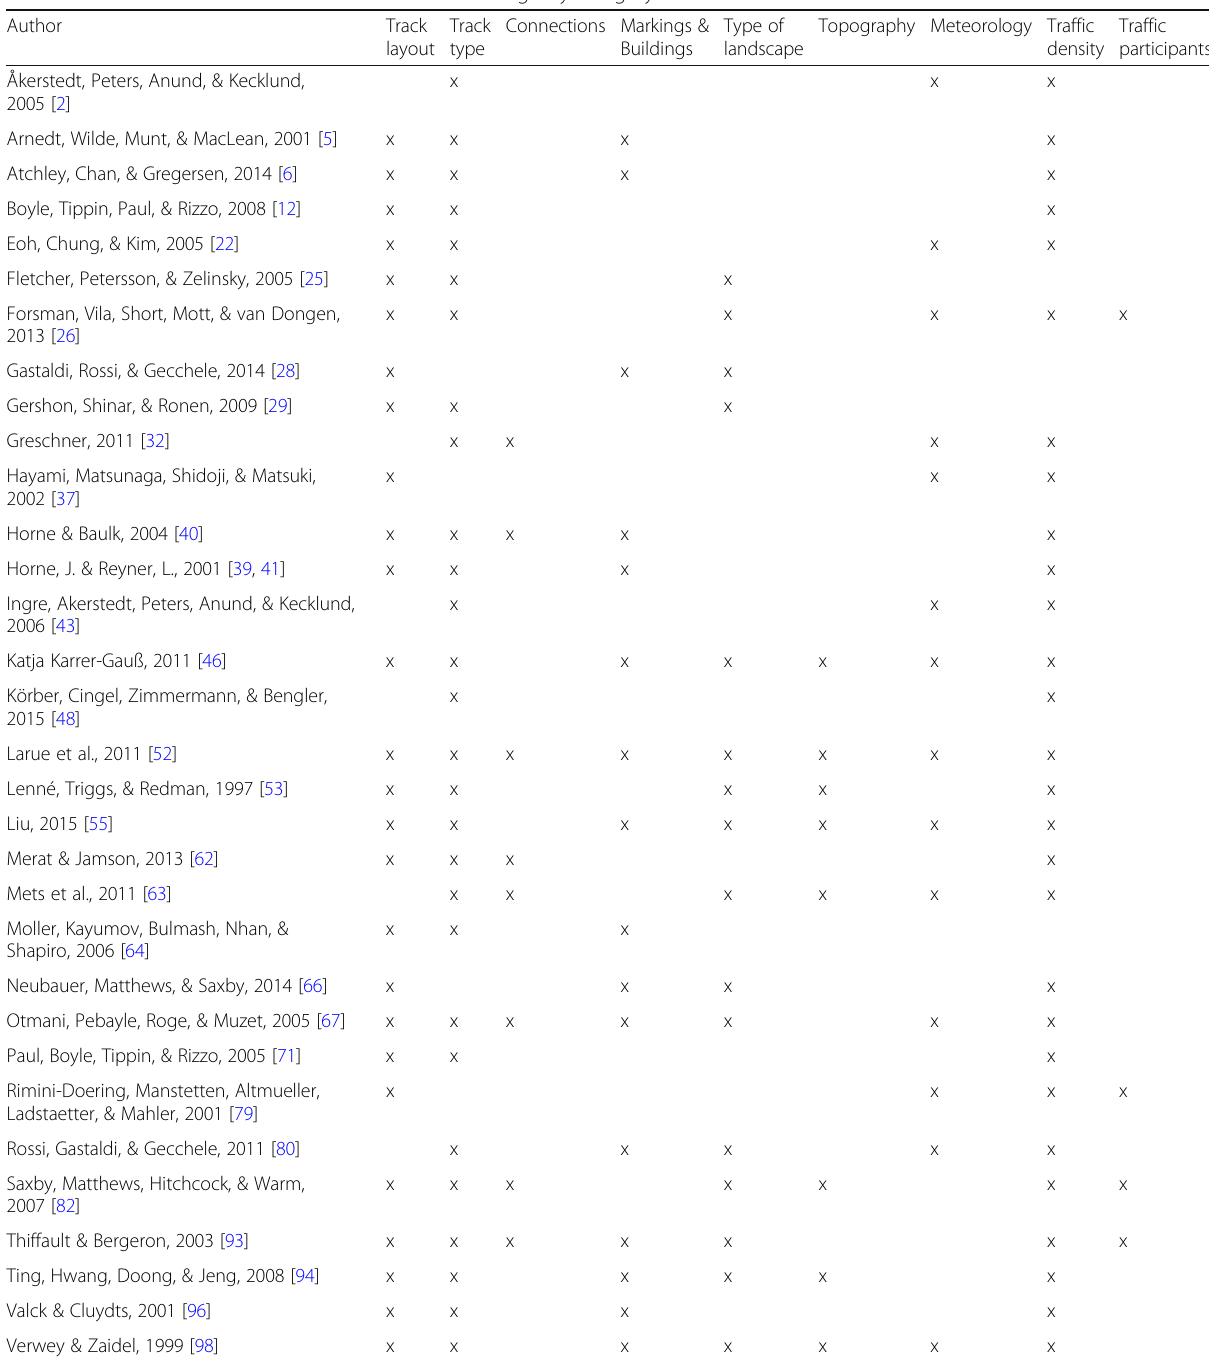
Table 1 Information in researched studies on route design by